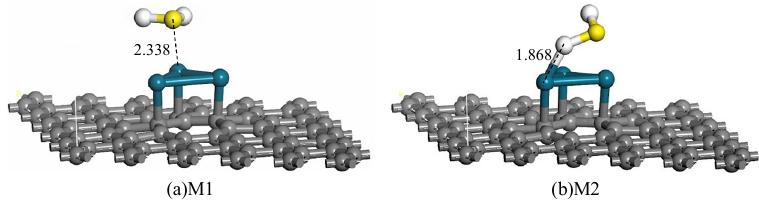
Figure 2. Adsorption structures of H 2 S on Pd 3 -graphene surface (distance in Å). Table 1. Structural parameters of H 2 S adsorption systems on Pd 3 -graphene surface. Position represents the approaching way, for instance, S–Pd means the H 2 S molecule approaches the Pd atom